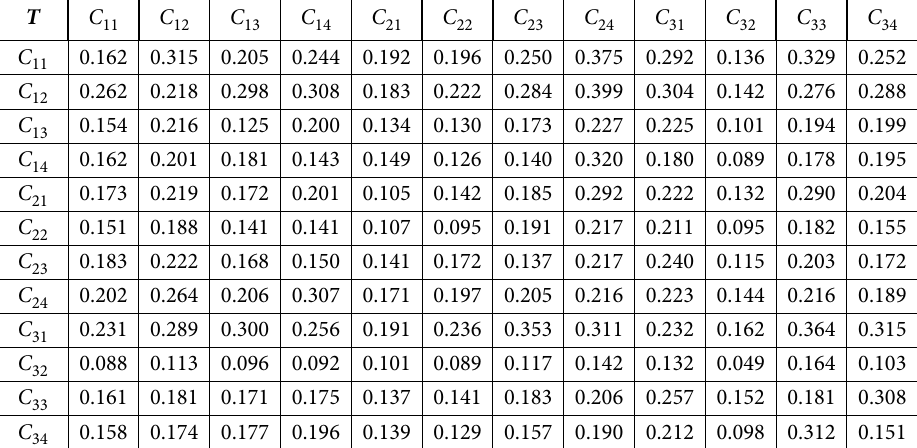
Table 5. Total influence significance-relation